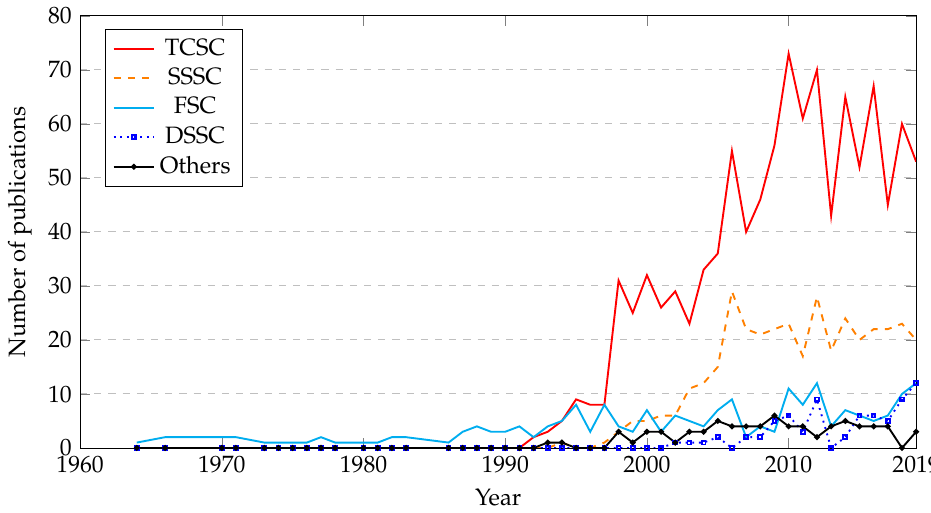
Figure 3. Time evolution of number of publications by